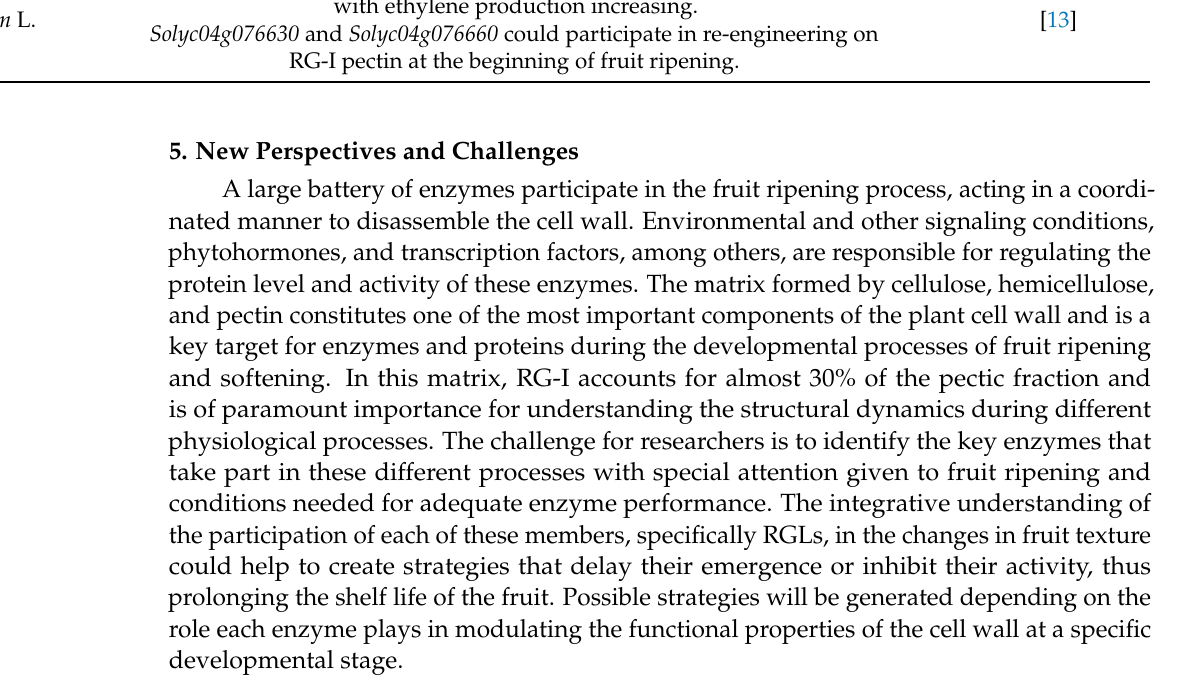
Table 2. Cont. Specie Results Reference RGL genes respond to abscisic acid, dehydration, and